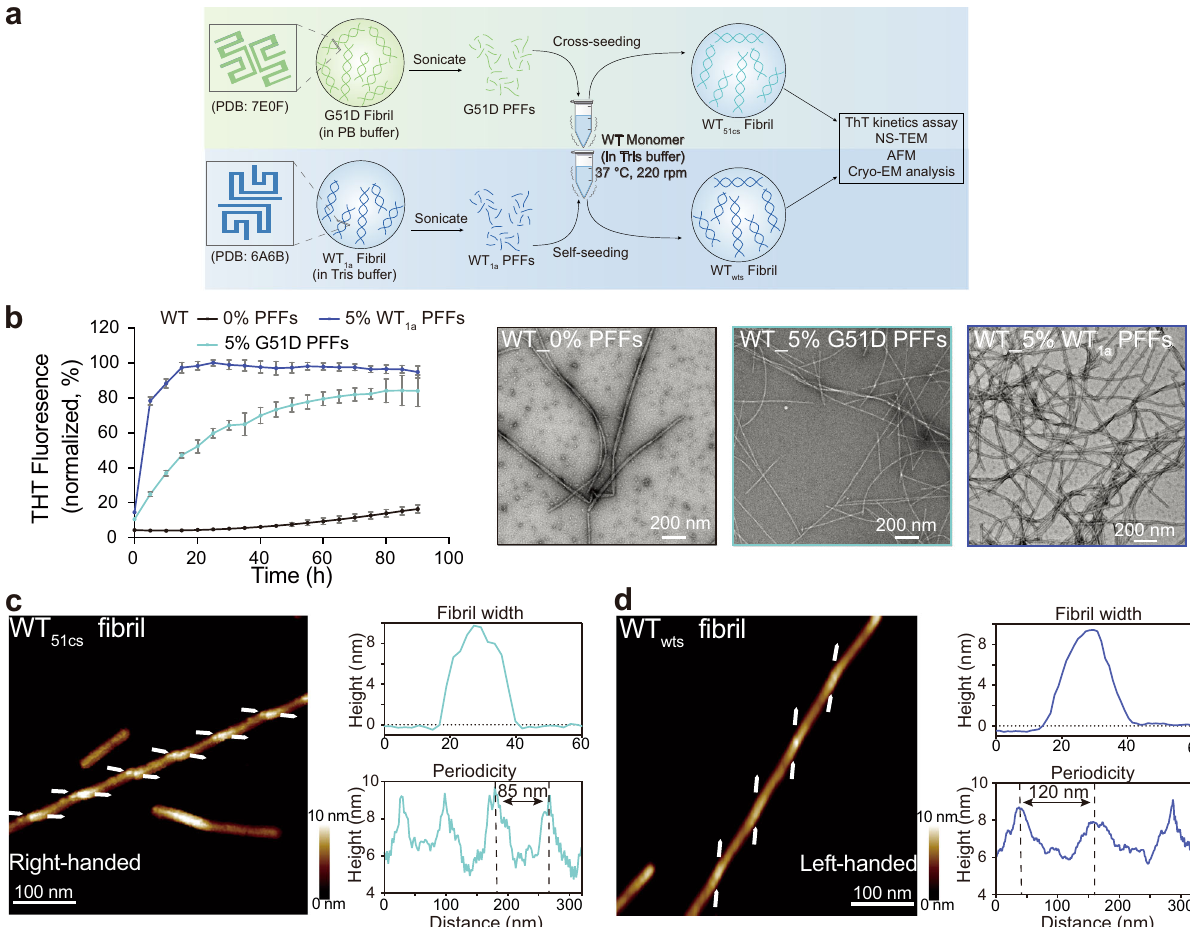
Fig. 4 Seeding of WT α -syn by both G51D and WT α -syn PFFs. a Schematic diagram of the seeding process. PDB IDs of WT 1a and G51D fi brils used for the seeding experiments are provided in parentheses. Buffer (50 mM Tris, pH 7.5, 150 mM KCl, 0.05% NaN 3 ) is referred to as Tris buffer. Buffer (50 mM phosphate buffer, pH 7.0, 50 mM NaCl, 0.05% NaN 3 buffer) is referred to as PB buffer. The schematic diagram was created from scratch. b Fibrillation of WT α -syn alone (colored in black) or in the presence of 5 mol% WT PFFs (colored in purple) and G51D PFFs (colored in cyan), respectively. Data are shown as mean ± s.d., n = 5 independent samples. The fi brils sampled at the end of the ThT kinetics assay were imaged by NS-TEM (right panel). Scale bar: 200 nm. c and d AFM images of the WT 51cs ( c ) and WT wts fi brils ( d ). The images represent reproducible results in three independent experiments. The arrows at both sides of the fi bril indicate the starting points of the fi bril protrusions to clarify the handedness. Images were acquired with a 1.45 Hz rate at 512 × 512 pixels. The fi bril width and periodicity were analyzed by the Nanoscope